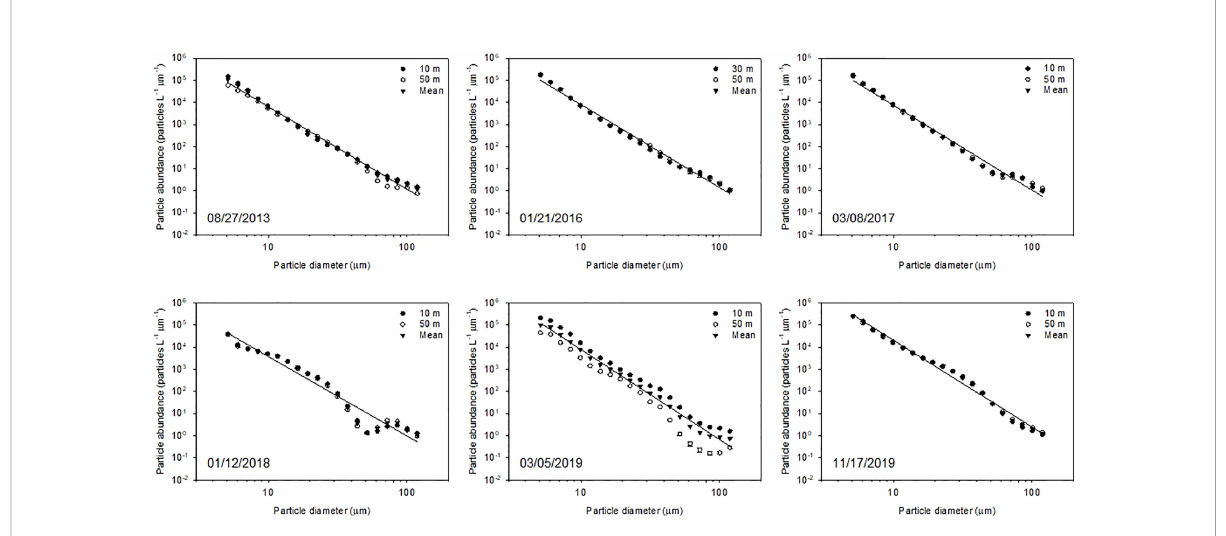
FIGURE 2 Particle size number distribution following the power-law model (Eq. 1) using double logarithmic transformation in the size range of 5.2 – 119 m m at depths of 10 and 50 m and averaged across the euphotic zone (see details in the main text) in the slope area. Error bars indicate standard error. The regression line was obtained using the ordinary least squares method for each sampling period. The statistical parameters of the regression are listed in Table